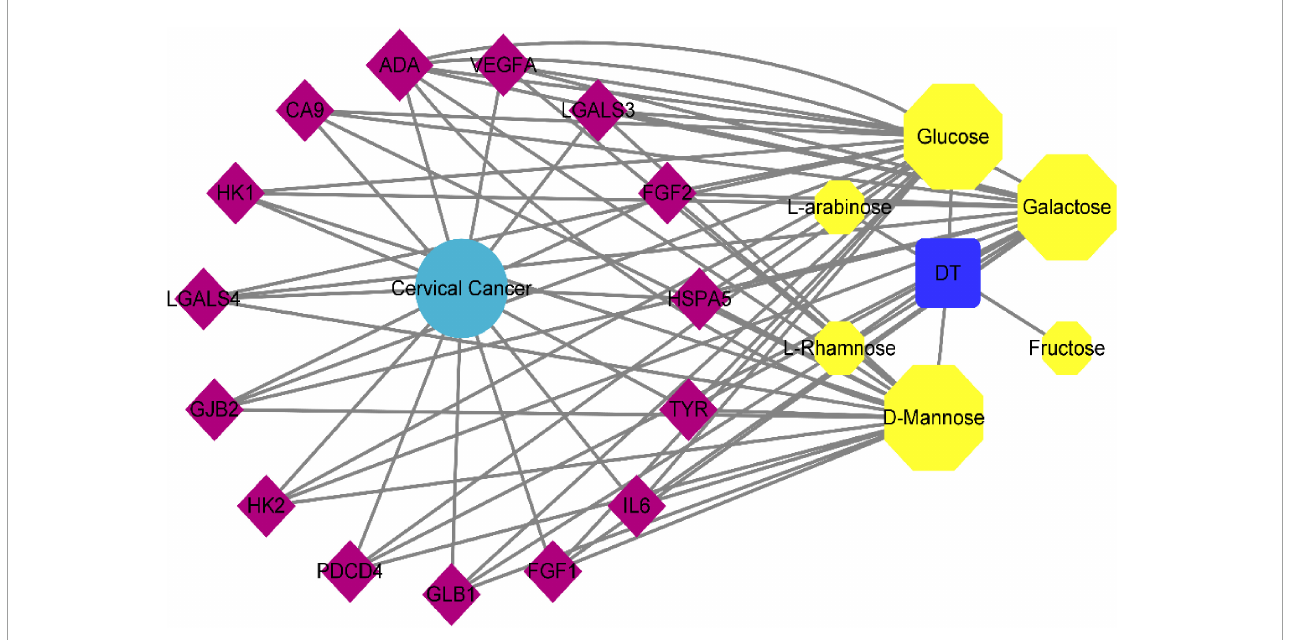
FIGURE2 Network diagram of “Seabuckthorn polysaccharides–target–cervical cancer” interaction.